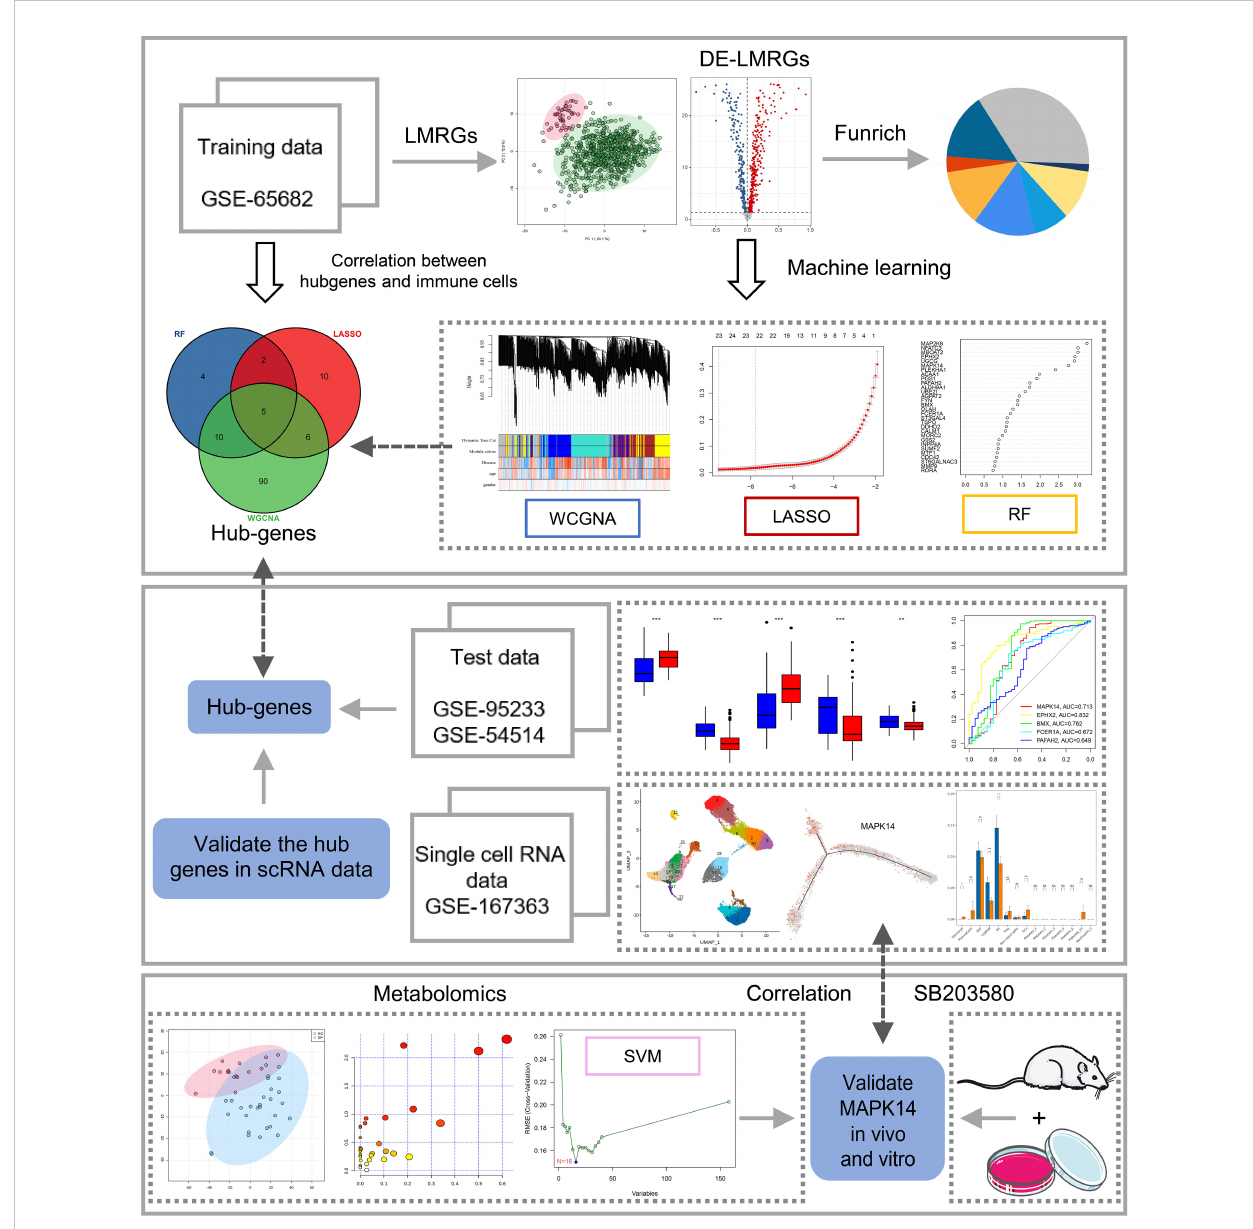
FIGURE 1 Study fl owchart. The scheme diagram of data analyzing. *: as compared with the Control group, P <0.05; **: as compared with the Control group, P<0.01; ***: as compared with the Control group, P<0.001; ns: as compared with the Control group,no signi fi cant difference. NA:Not